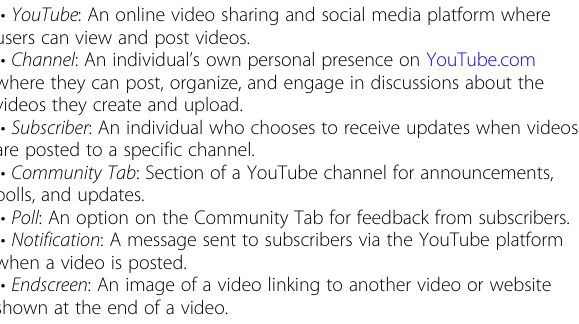
Table 1 Key Terms for the YouTube Video Sharing Platform (cid:129) YouTube : An online video sharing and social media platform where users can view and post videos. (cid:129) Channel : An individual ’ s own personal presence on YouTube.com where they can post, organize, and engage in discussions about